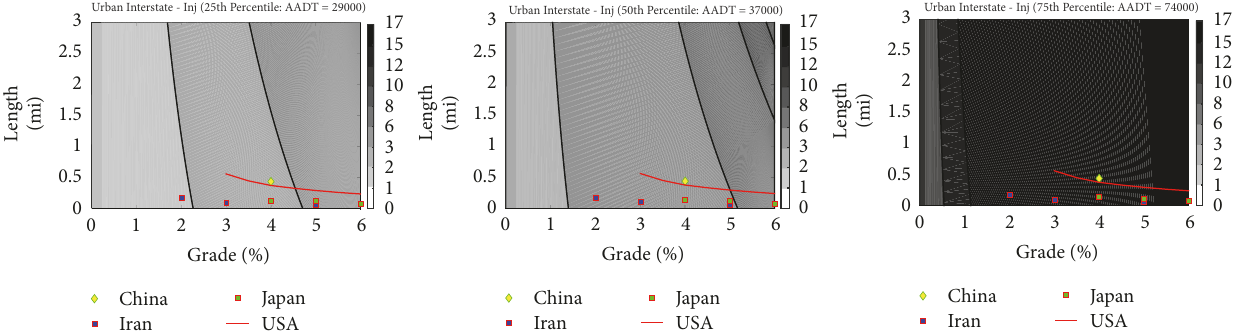
Figure 9: Prediction of urban interstate injury crash frequency.